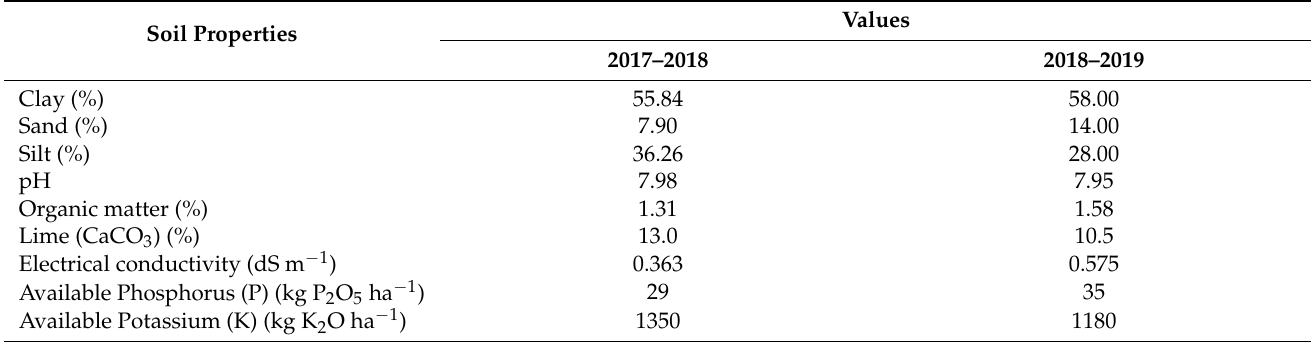
Table 2. Major physical and chemical properties of the trail field soils (0–20